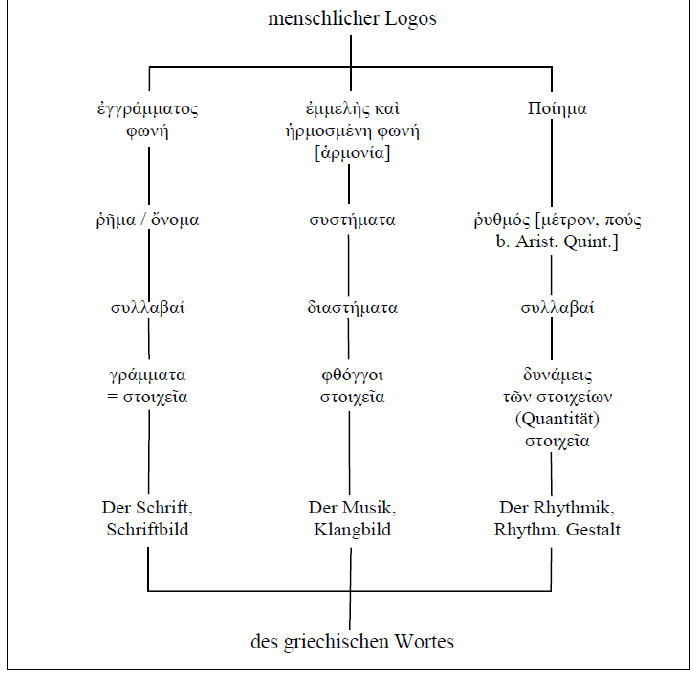
Figure 1. Hermann Koller’s Presentation of the Phonetic, Melodic and Rhythmic Combinatories which organized Language and Music in Early Greece.